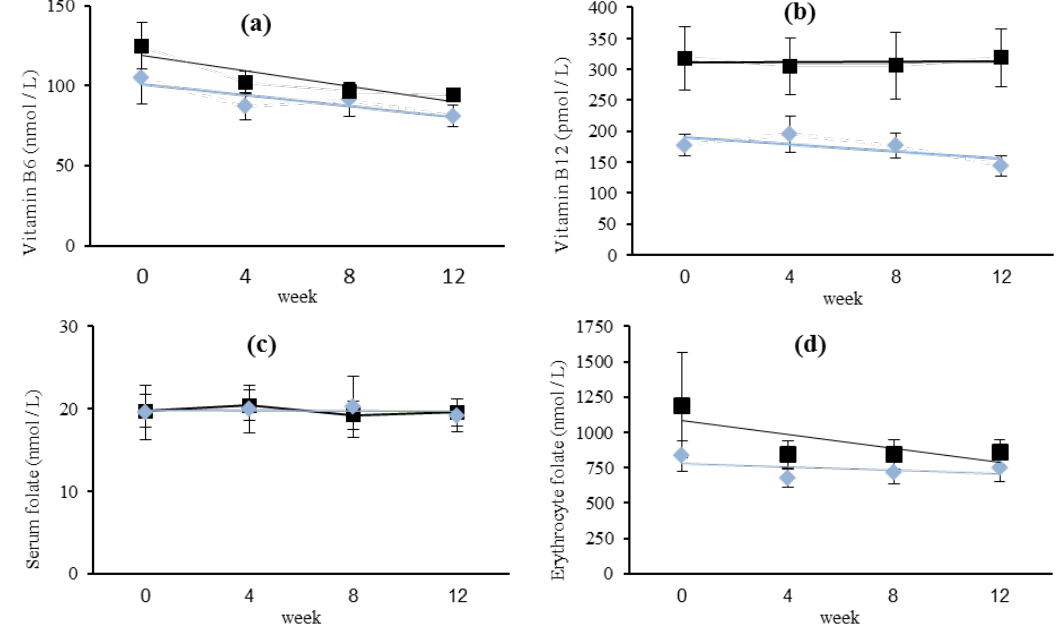
Figure 2. Serum vitamin B ( a ), vitamin B ( b ) and folate ( c ), and erythrocyte folate ( d ) 6 12 concentrations (mean ± SE) at four time-points for OCP a users ♦ ( n = 9) and non-OCP users ■ ( n = 13). Missing data for one OCP user at four